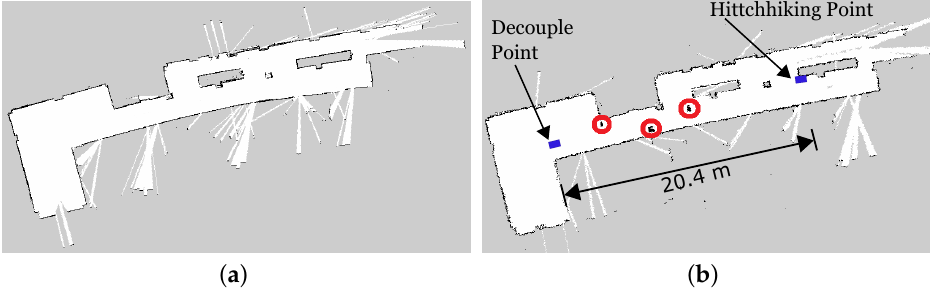
Figure 10. Experiment 1. ( a ) Initial map without obstacles; ( b ) Updated map with new obstacles. Driver robot transferred the obstacle coordinates (marked in red) to the hitchhiker. Table 1. New obstacle info transferred to the